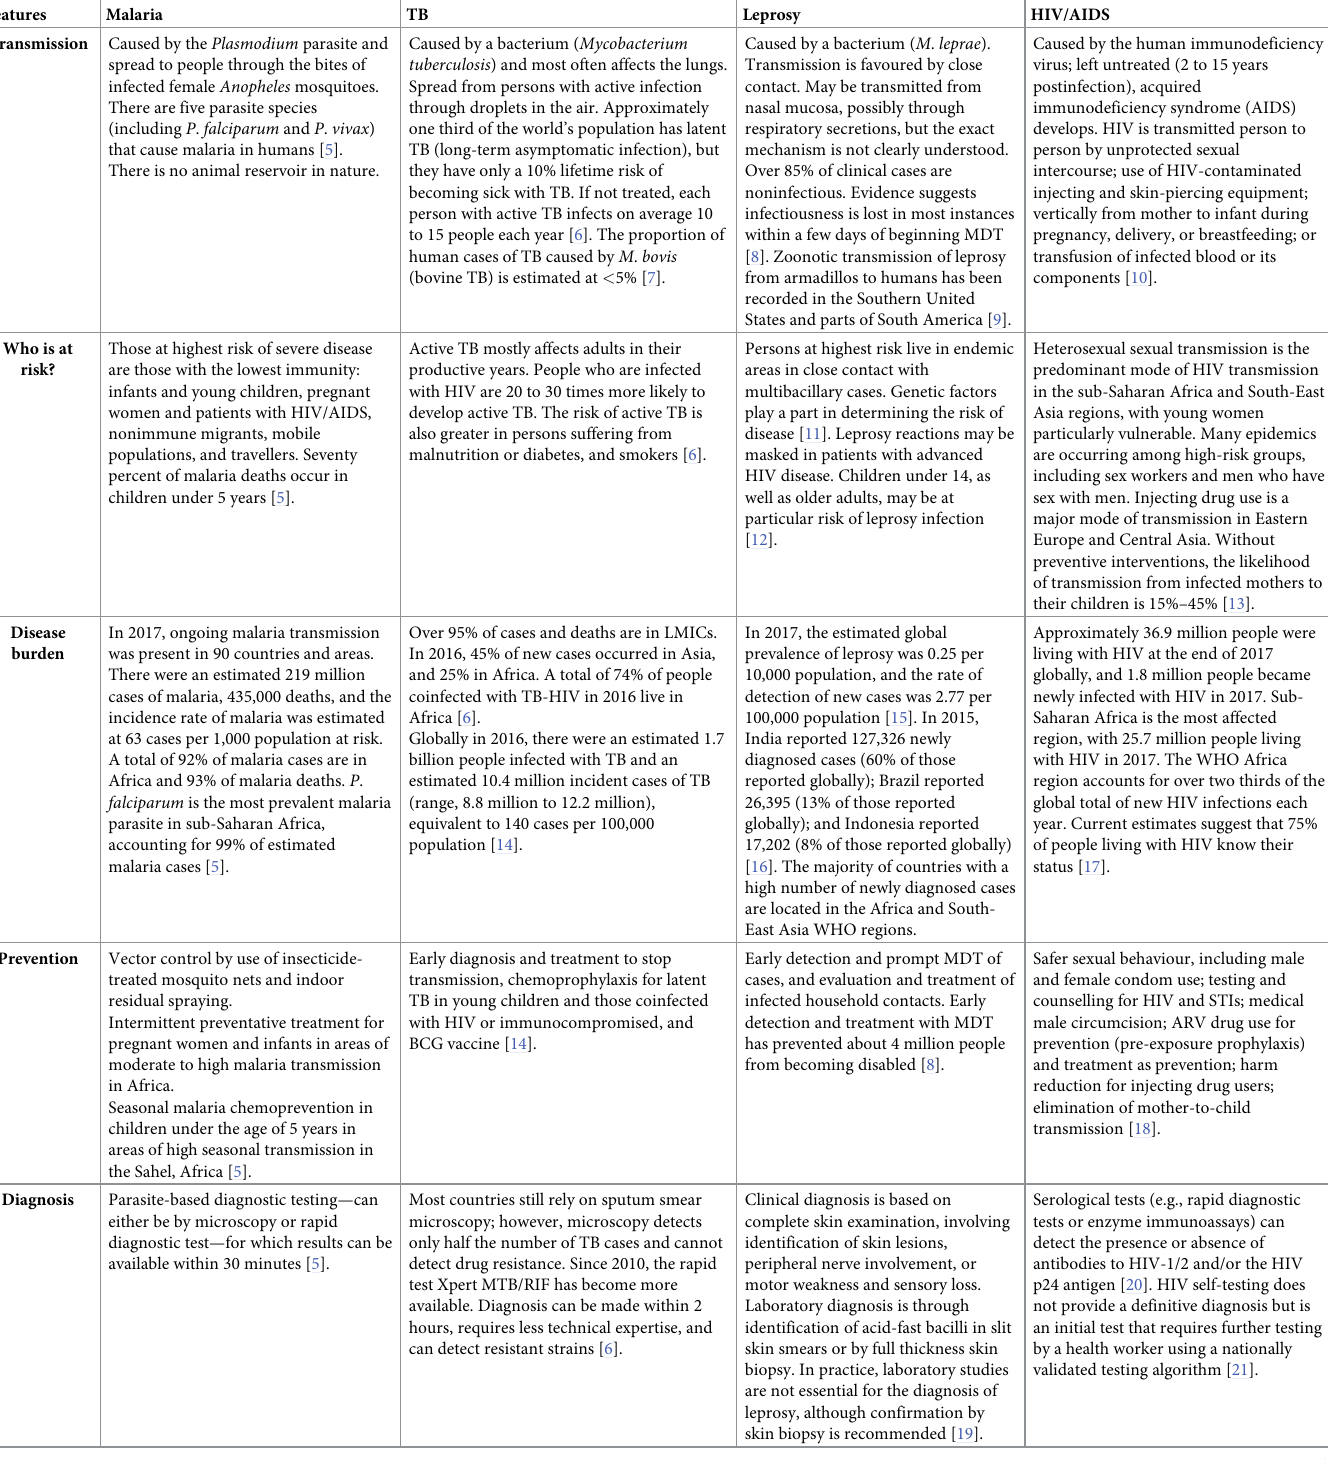
Table 2. Epidemiological comparison of the four diseases considered.